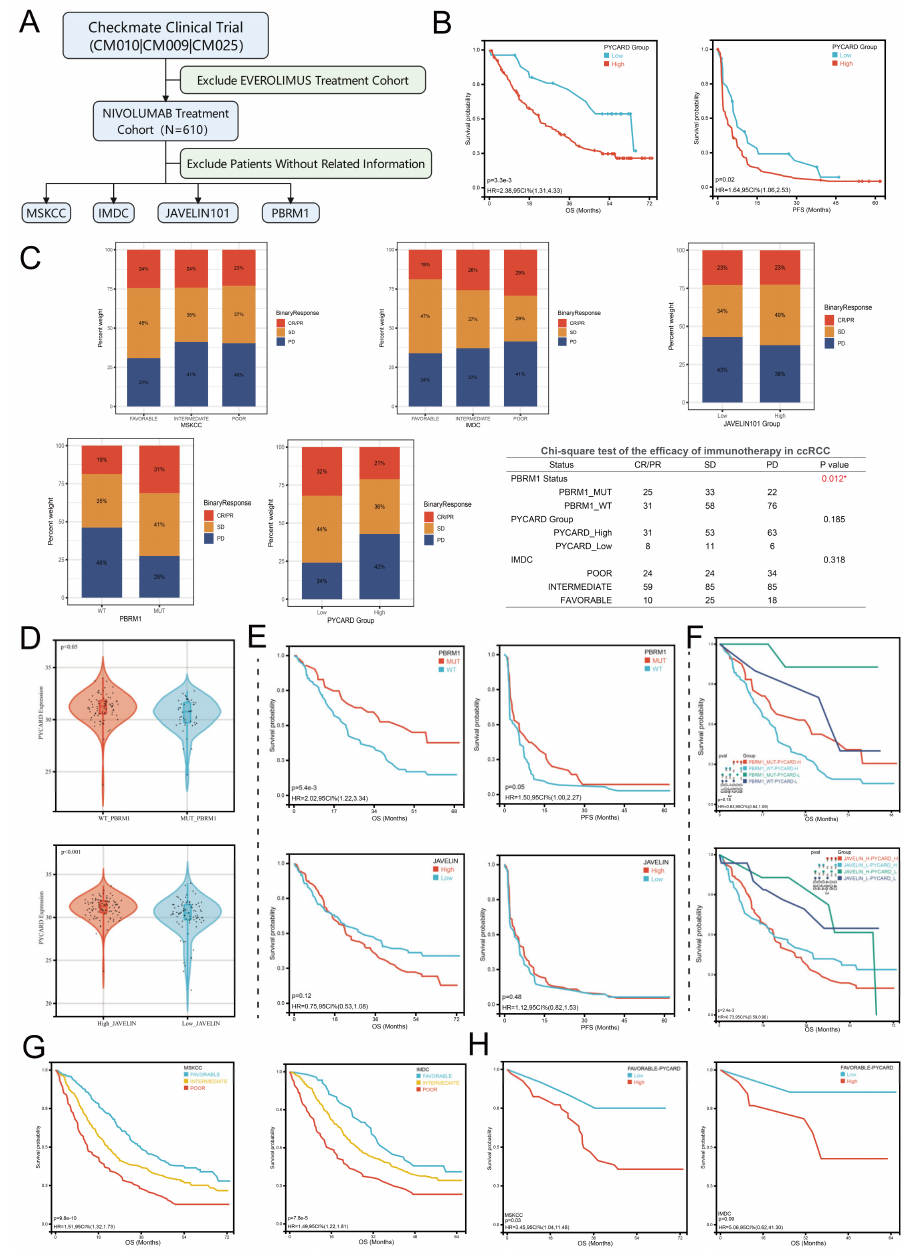
Figure 6. PYCARD expression is associated with immune response. ( A ) The workflow for analyzing associations between PYCARD and immunotherapy response. ( B ) Higher PYCARD expression is associated with OS ( p = 0.003) and PFS ( p = 0.02) ( C ) PBRM1 genomic status is associated with ORR ( p = 0.012), while PYCARD expression demonstrated the trend but was not significant ( p = 0.185). The Chi-square test was used for the analysis. ( D ) PBRM1 genomic status ( p < 0.05) and JAVELIN signature ( p < 0.001) are associated with PYCARD expression in the nivolumab treatment cohort. ( E ) Survival analysis of PBRM1 genomic status and JAVELIN signature in the nivolumab treatment cohort. Only PBRM1 status is significantly associated with OS ( p = 0.0054). ( F ) Survival subgroup analysis of PYCARD plus PBRM1 genomic status or JAVELIN signature in nivolumab treatment cohort. ( G ) Survival analysis of MSKCC and IMDC subgroups in nivolumab treatment cohort. ( H ) MSKCC- and IMDC-favorable subgroups showed the trend that higher PYCARD expressions are associated with worse OS. (ORR, objective response